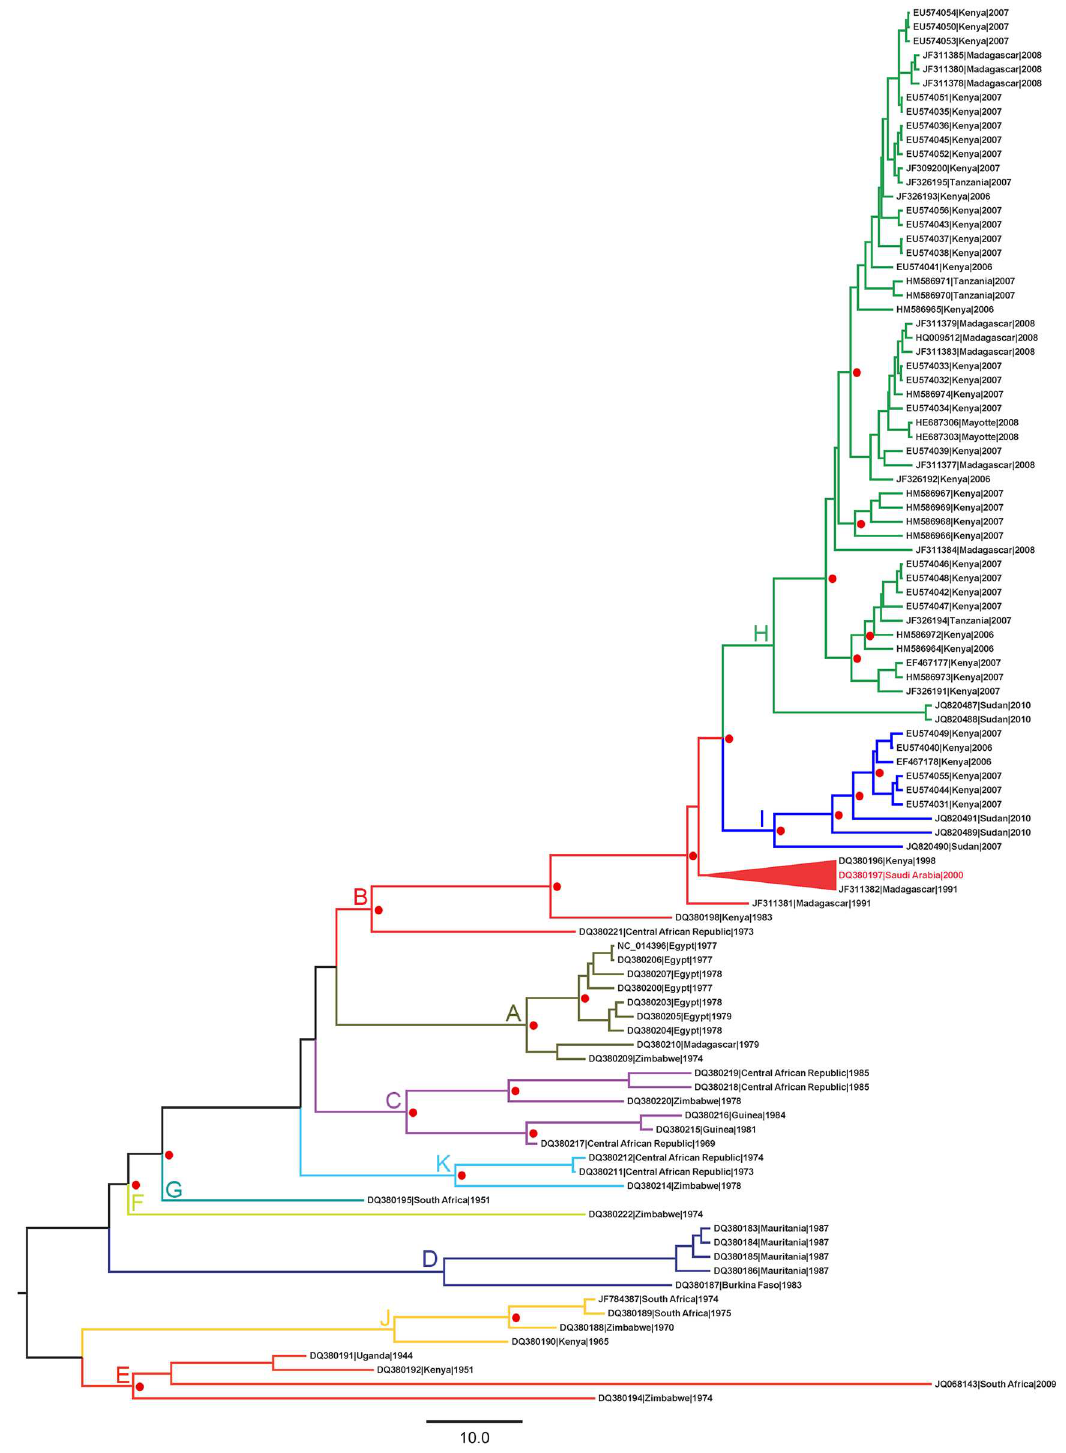
Fig 1. Maximum Clade Credibility tree based on all sequences of the medium minigenomic segment (M) of RVFV isolates in the study. NCBI accessionnumber, country, and date of samplingare presented at the tree tips. Tree branches are colored and labelledalphabetically by lineage (A to K). Lineagenomenclature is from Bird et al. [32]. The red triangleidentifiesthe clade containing isolates from both Saudi Arabia and Africa. Cladeswith posterior probability > 0.9 are labelledwith red